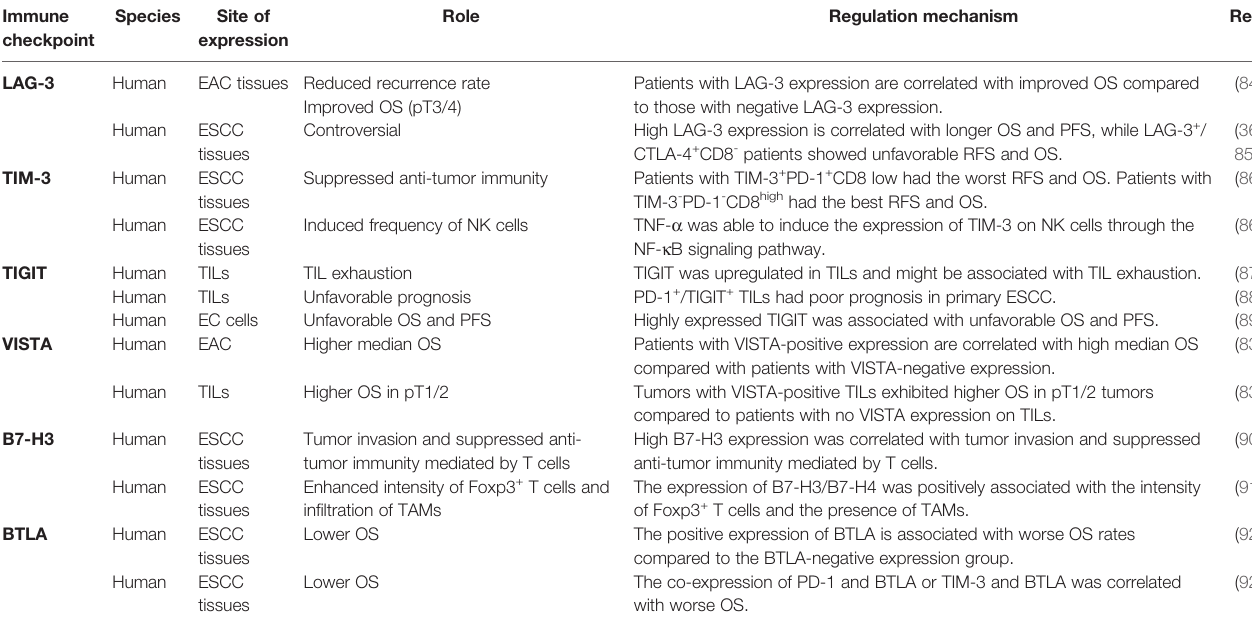
TABLE 1 | The therapeutic and prognosis value of novel immune checkpoint pathways in EC. Immune checkpoint